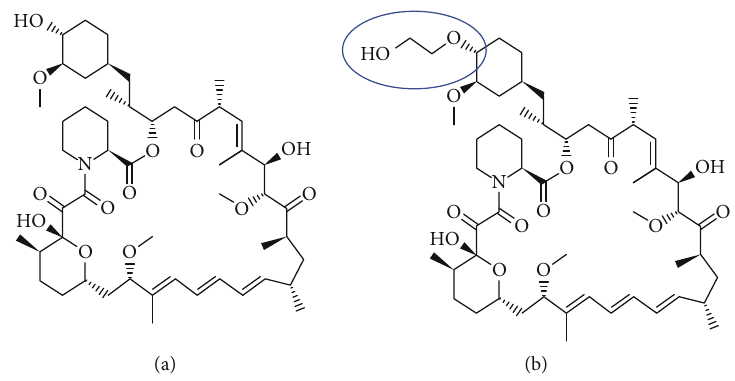
Figure 1: Drug comparison. Chemical structure of (a) sirolimus and (b)